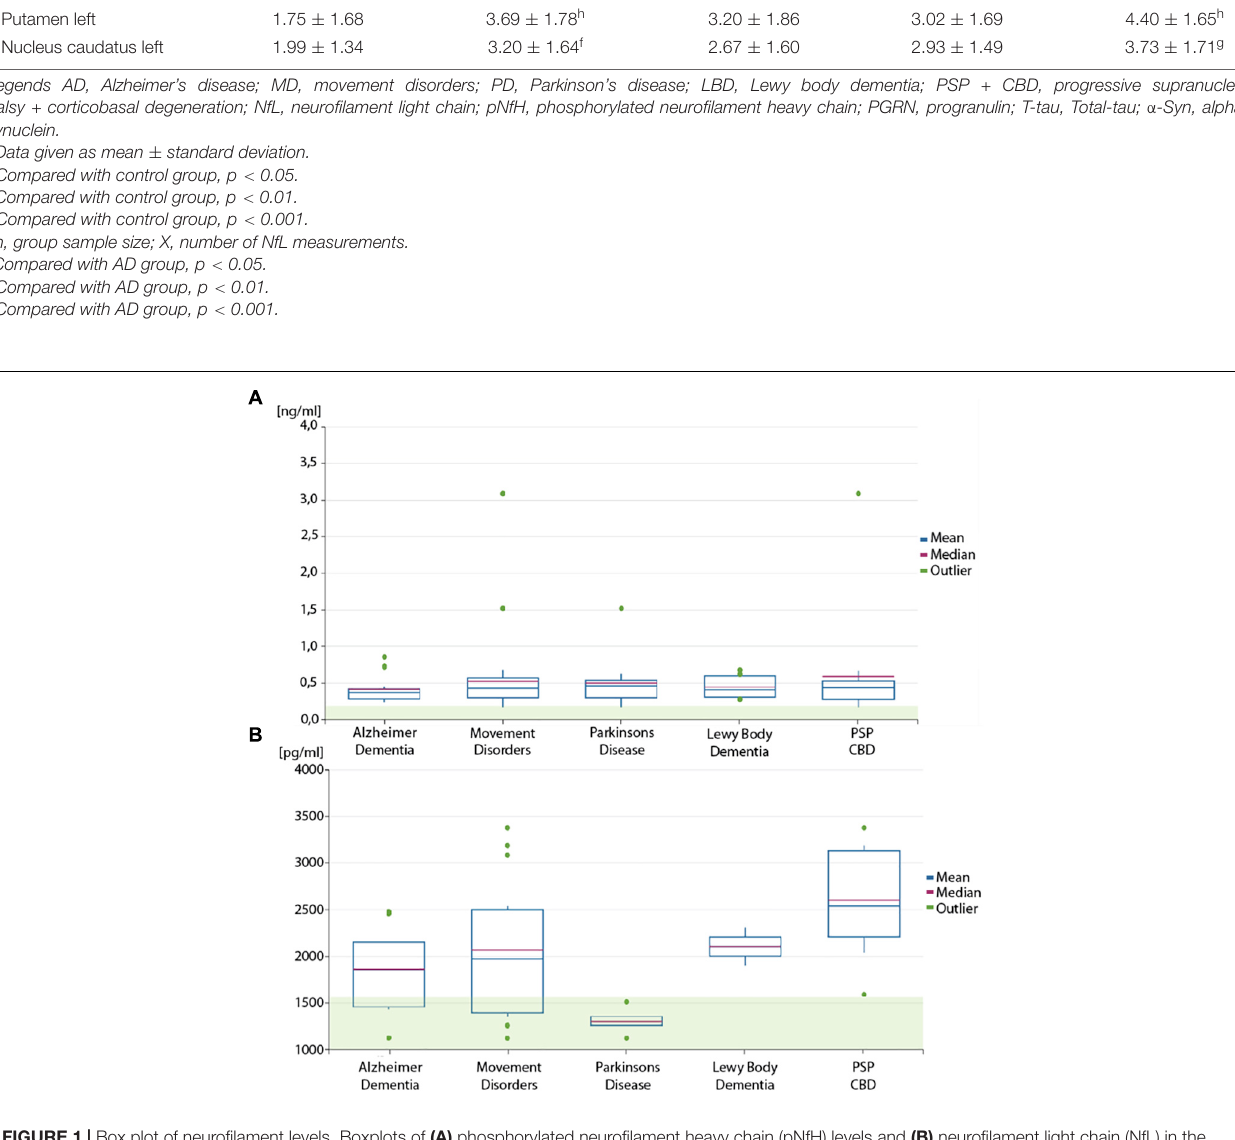
FIGURE 1 | Box plot of neurofilament levels. Boxplots of (A) phosphorylated neurofilament heavy chain (pNfH) levels and (B) neurofilament light chain (NfL) in the cerebrospinal fluid (CSF) of the disease cohorts and subgroups. The transparent green box is indicating the normal range (mean + 1 standard deviation).